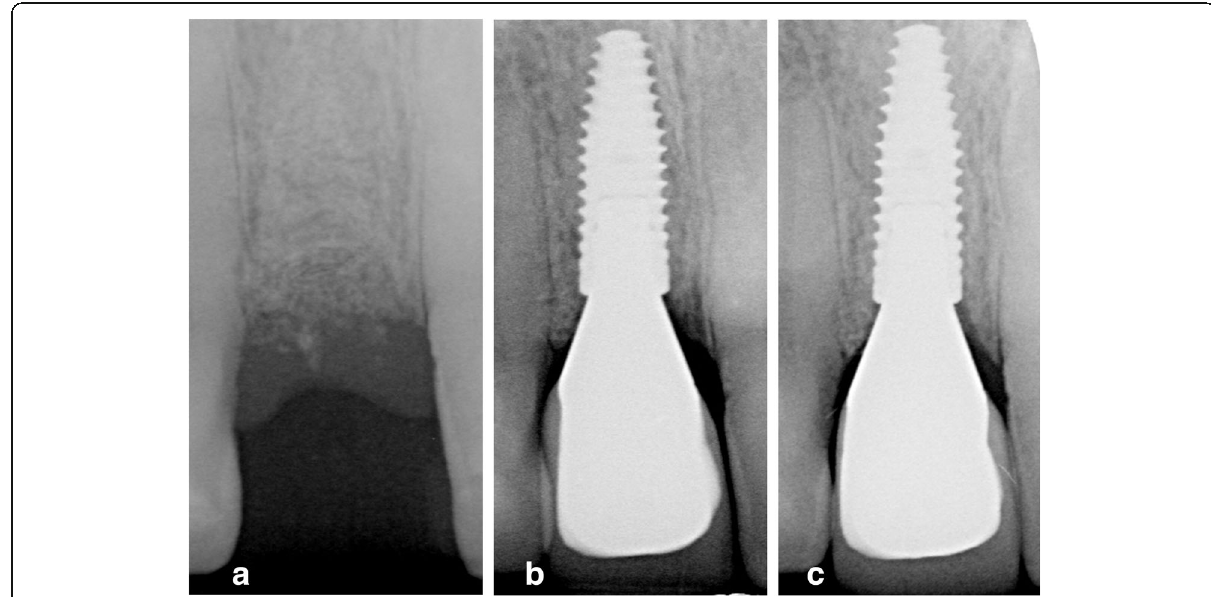
Fig. 1 Bone level. a Prior to implant placement (3 months after preservation). b One month after definitive restoration placement. c